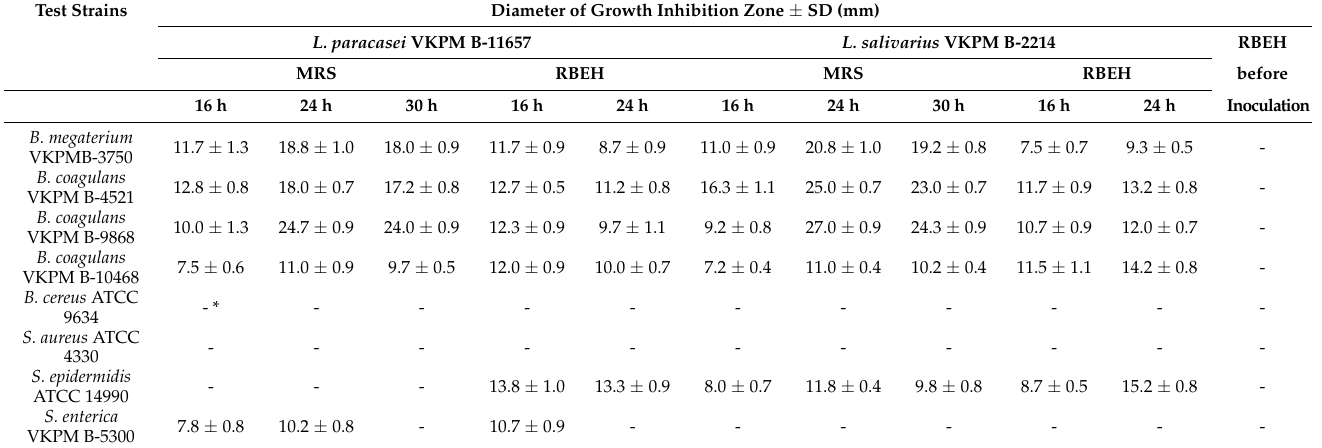
Table 5. Diameters of the test strains growth inhibition zones for the CFS of lactobacilli cultivated in MRS and